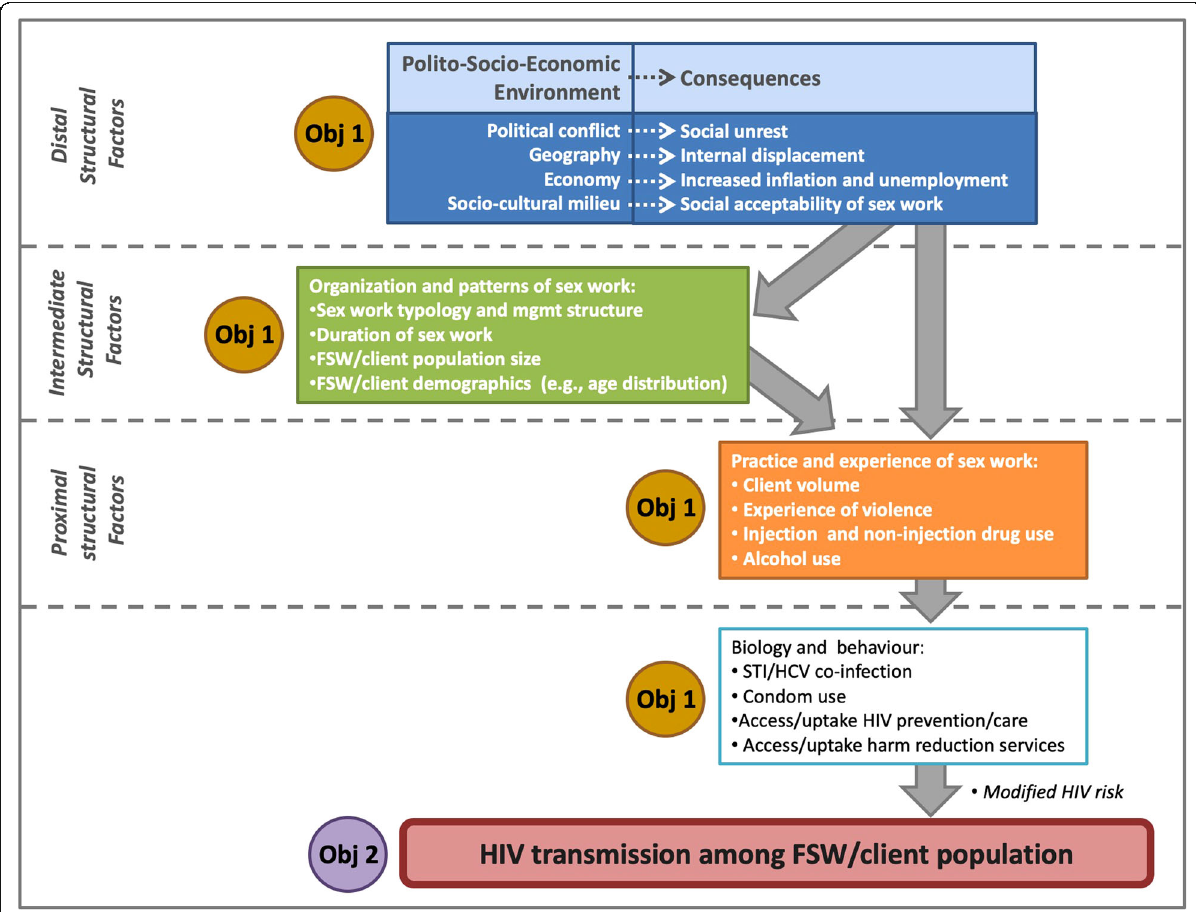
Fig. 1 Conceptual Framework for HIV